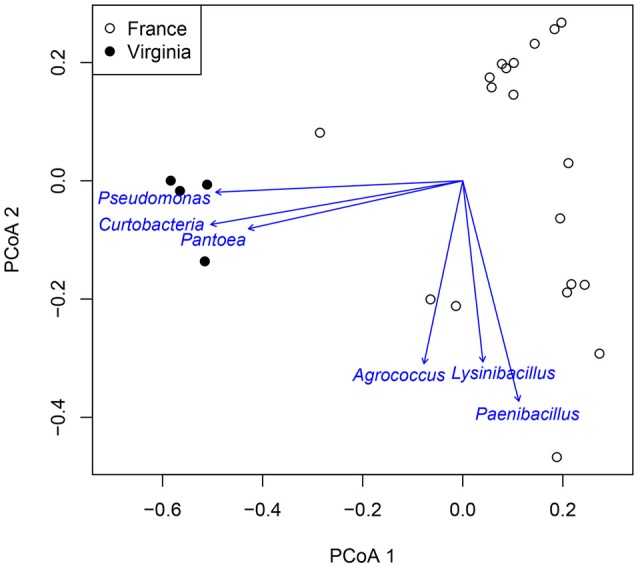
PCoA of Virginia and France genus data for TSA media. Arrows point to the region of most rapid increase in the projection. Arrow length is scaled by strength of correlation to the projection.